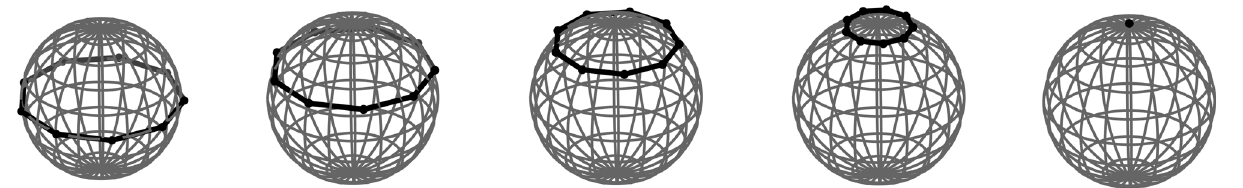
Fig. 3 Convergence to synchronization. Evolution of a con fi guration with 9 agents connected by a cycle graph on the sphere S 2 . The con fi guration is continuously deformed from the equator into a point on the north pole (i.e., synchronization) by letting the latitude parameter s in the map given by (Eq. 9) decrease from s = π /2 to s = 0. An equivalent version of this continuous deformation is not possible for the standard Kuramoto model since the circle is a simply connected